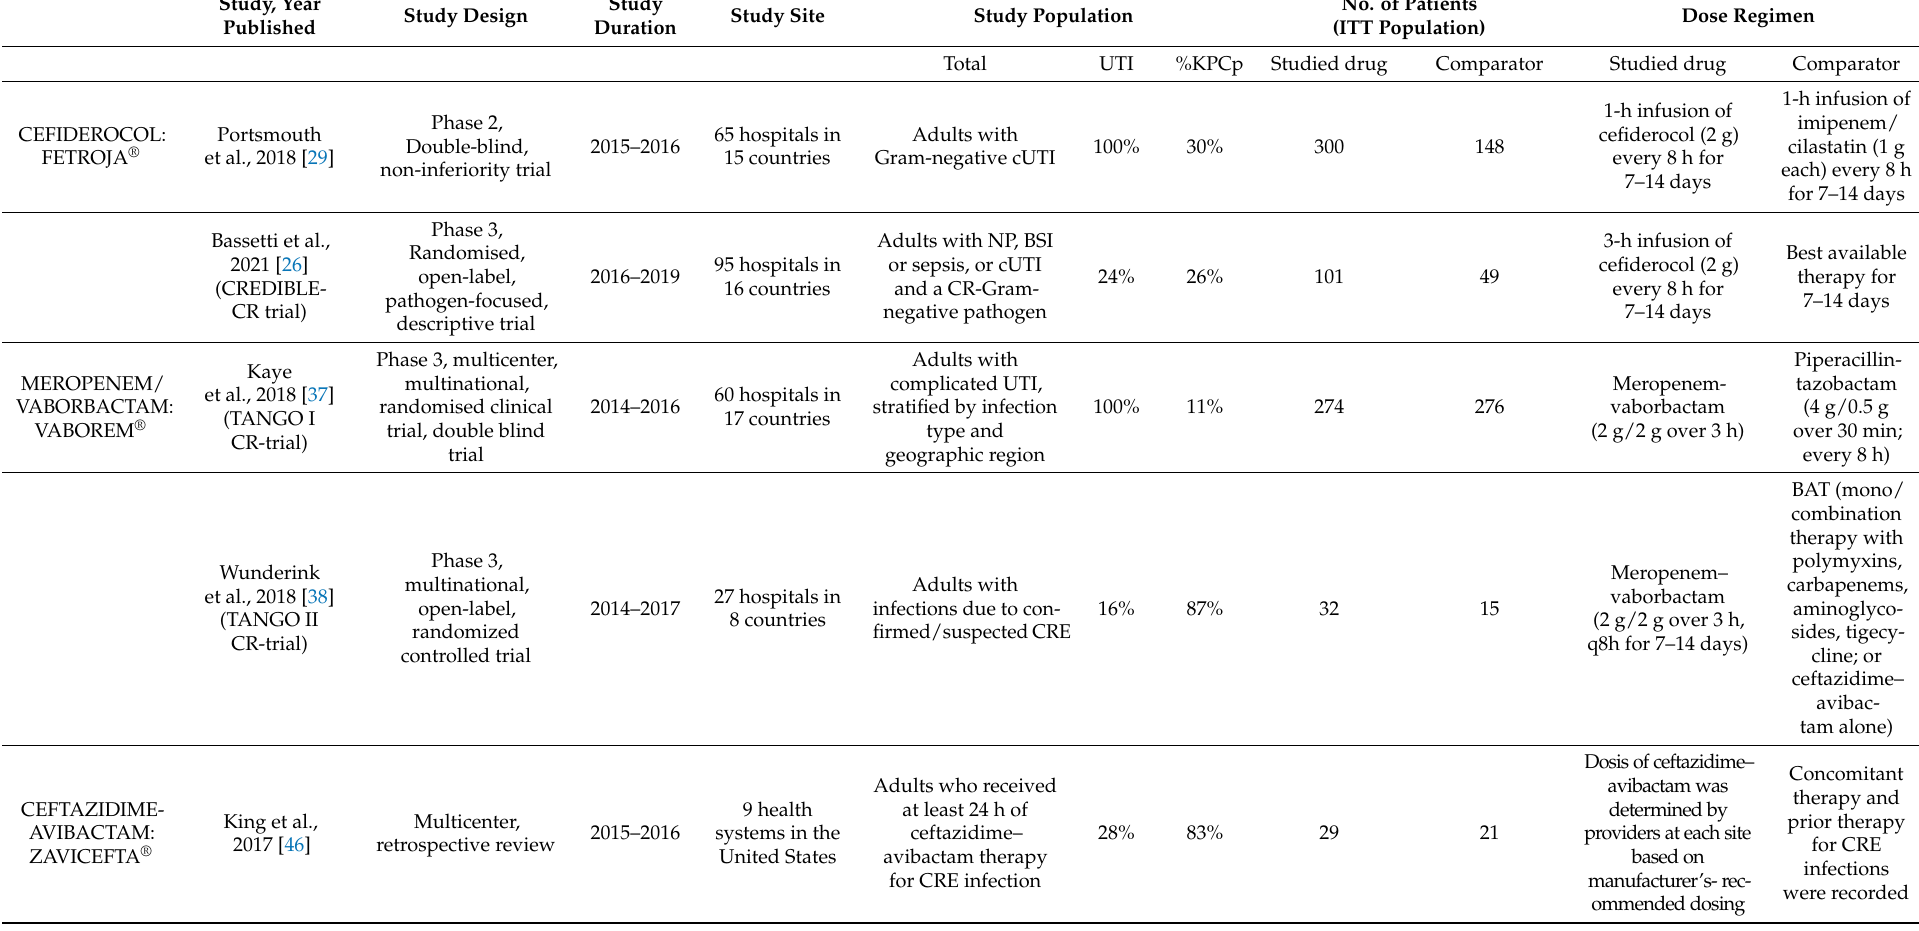
Table 1. Characteristics of the main studies